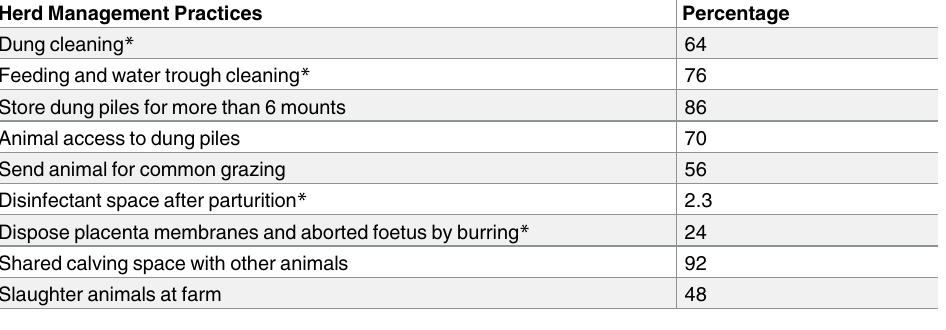
Table 5. Herd management practicesposing a risk for brucellosis transmission within herd reported by smallholder dairy farmersparticipating in a cross-section study on brucellosis in Pakistan ( n = 420